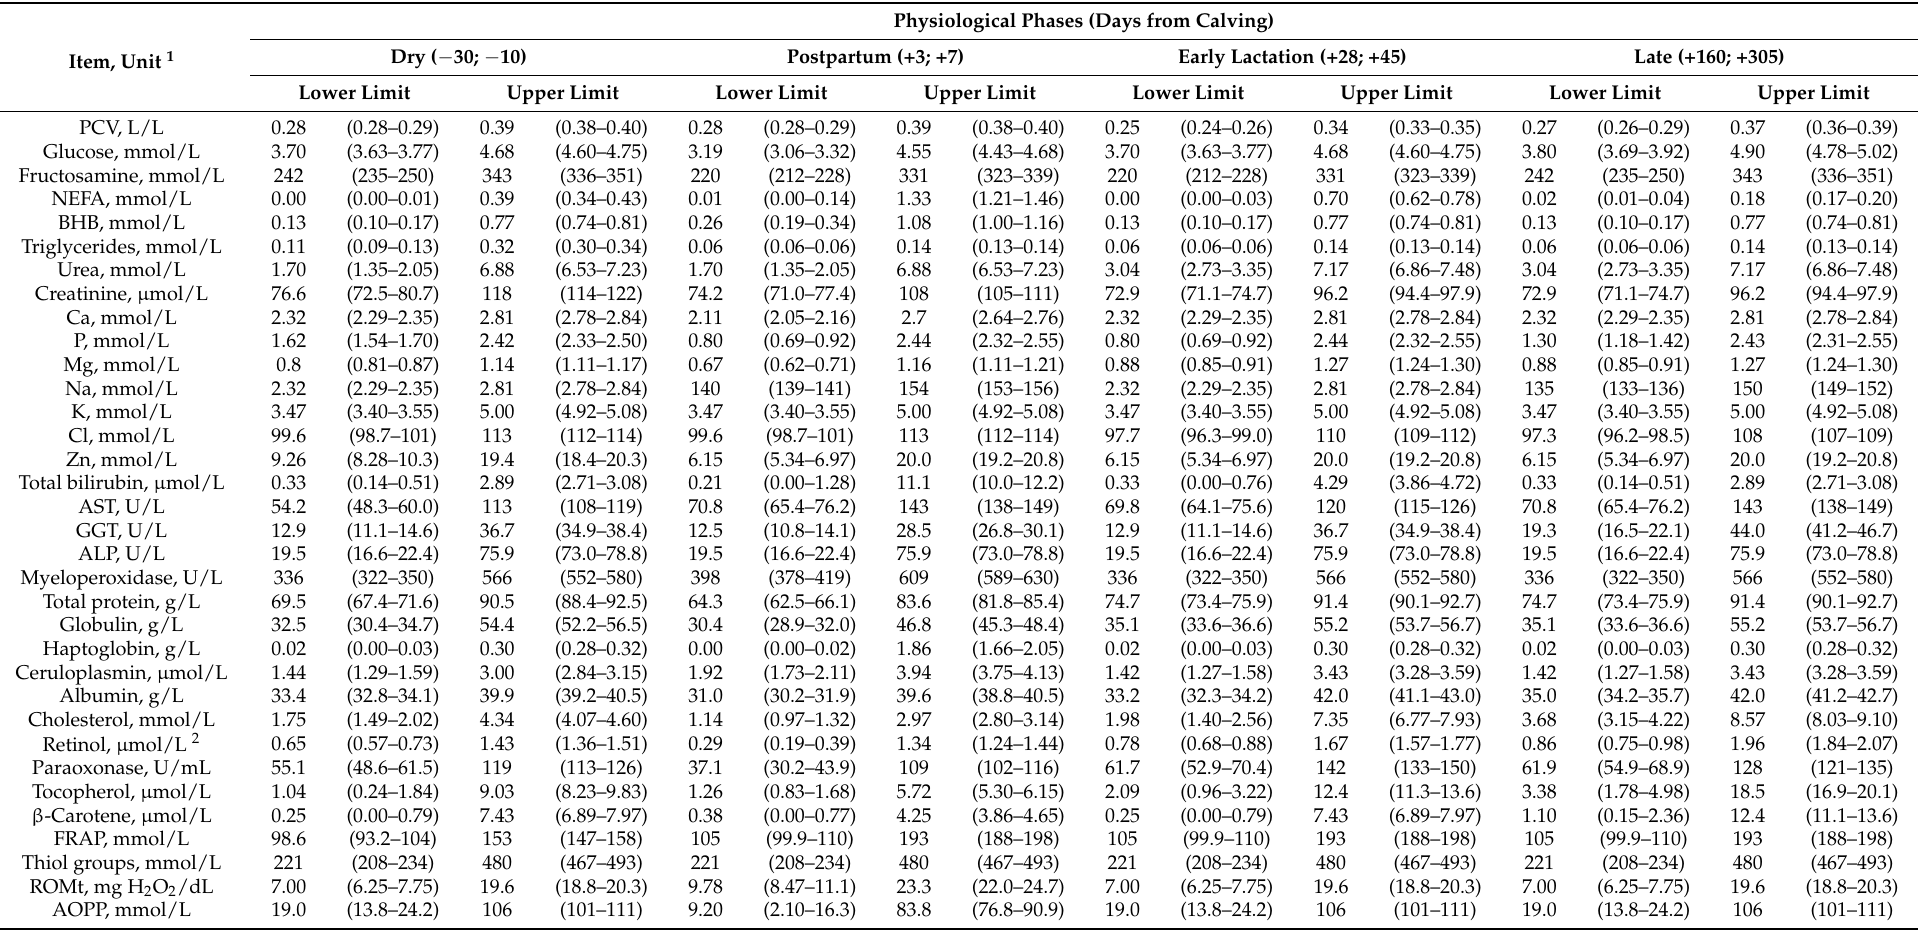
Table 4. Reference intervals (expressed as lower and upper limits (confidence intervals for 95% observations referred to the reference interval extreme values)) for plasma analytes assessed in healthy, high welfare raised multiparous Holstein dairy cows during the pivotal stages of the lactation cycle.